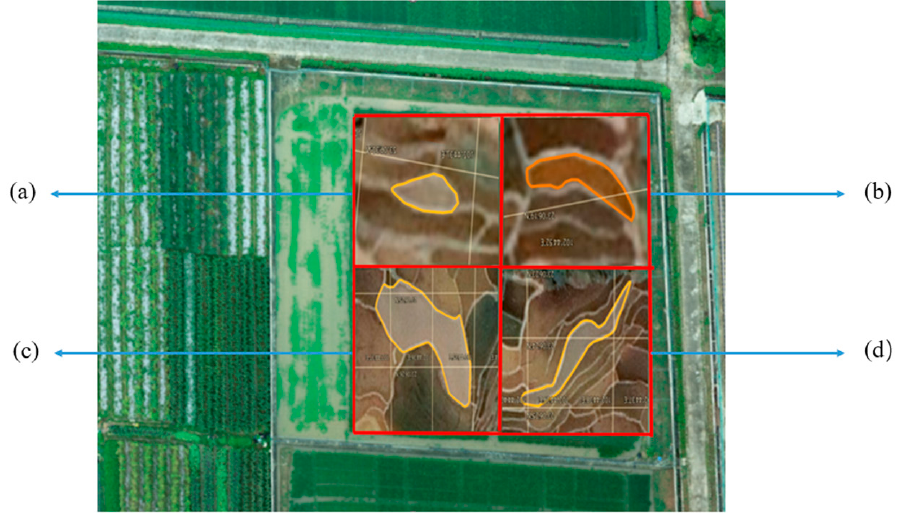
Figure 10. The profile and number of the field block of the verification test. ( a ) represents the field block that simulates the outline of field block 1; ( b ) represents the plot that simulates the contour of field block 2; ( c ) represents a plot that simulates the contour of plot 3; and ( d ) represents a plot that simulates the contour of plot 4.